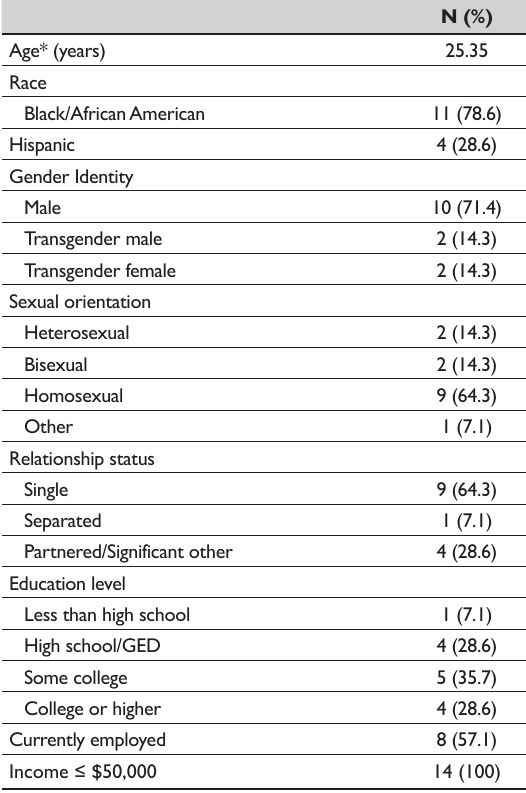
Table 1: Demographics of participating